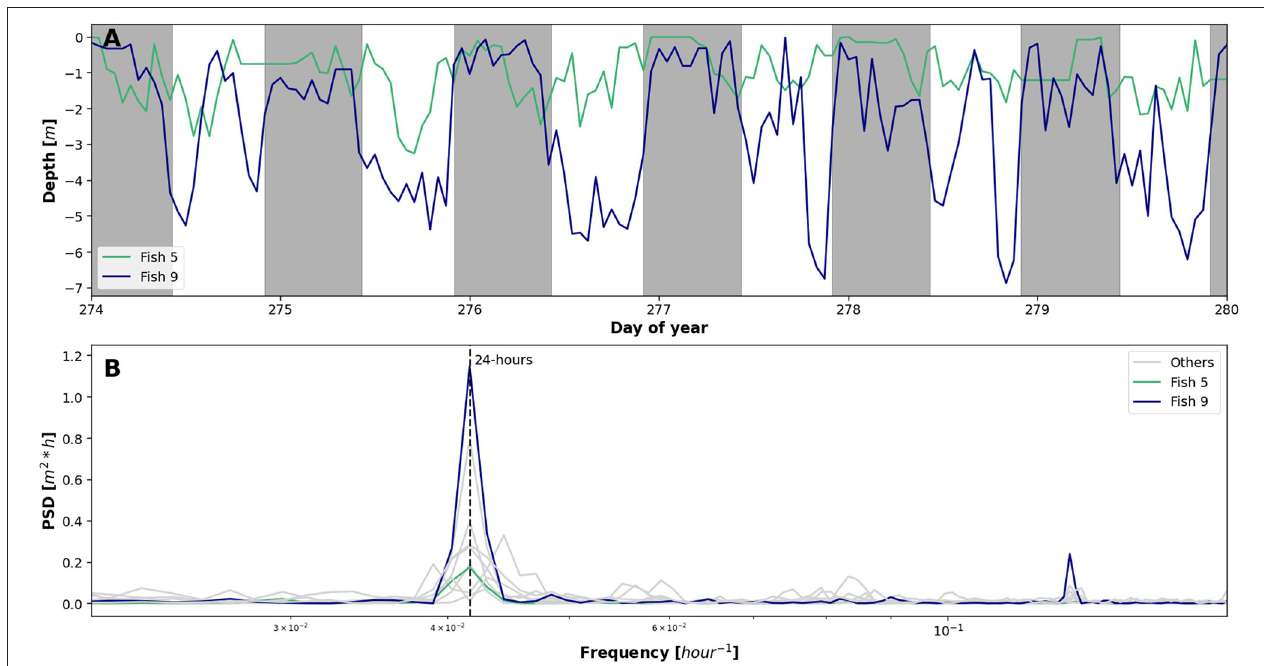
FIGURE 5 | Spectral analysis of tagged fish velocity [ms − 1 ]. (A) One-week one hour rolling mean time series of two individuals: Fish 5 (green) and Fish 9 (blue) with night highlighted in grey. (B) Power spectral density plot using 1 h rolling mean of all individuals highlighting fish 5 and 9 where frequency is in hours.